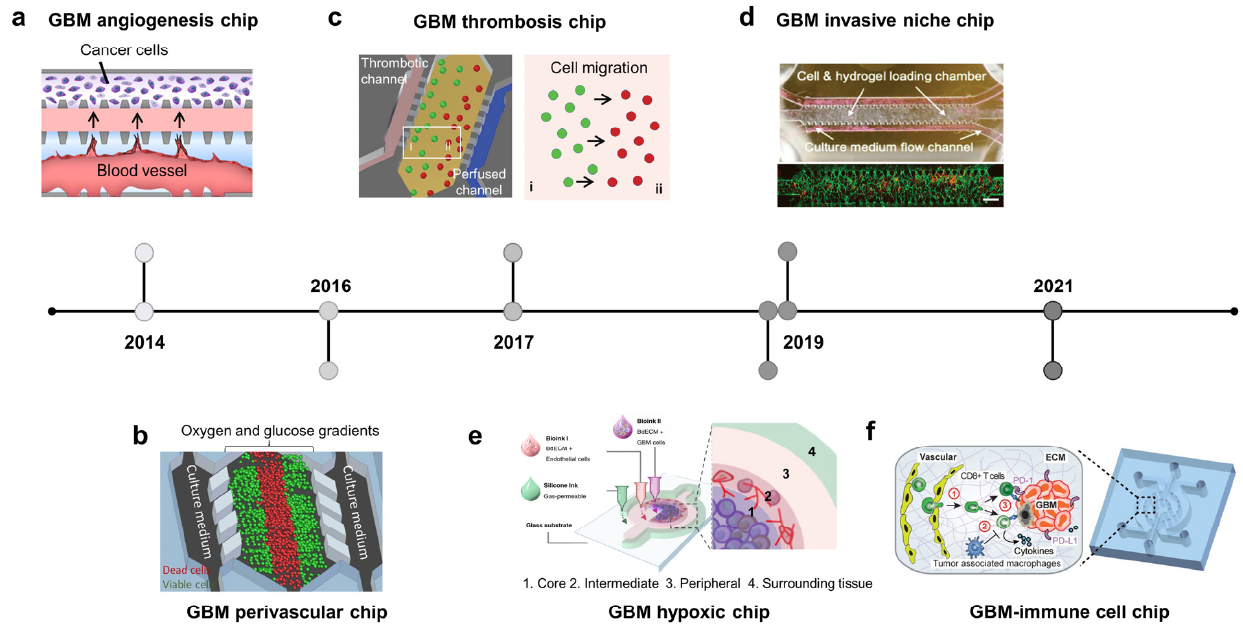
Figure 2. Brain cancer-on-chip. A timeline showing the hallmarks of glioblastoma (GBM) on the chips. ( a ) GBM angiogenesis chip: microvessels were formed adjacent to tumor cells, allowing f the generation of the soluble factors’ gradient between two channels (adapted with permission from Ref. [77]. Copyright 2014, AIP Publishing). ( b ) GBM perivascular chip: gradients of oxygen and glucose were generated on a microfluidic chip. Dead cells were observed in the central chamber with low concentrations of nutrients/oxygen (adapted with permission from Ref. [79]. Copyright 2016, CC BY 4.0). ( c ) GBM thrombosis chip: thrombotic channels were fabricated by collagen